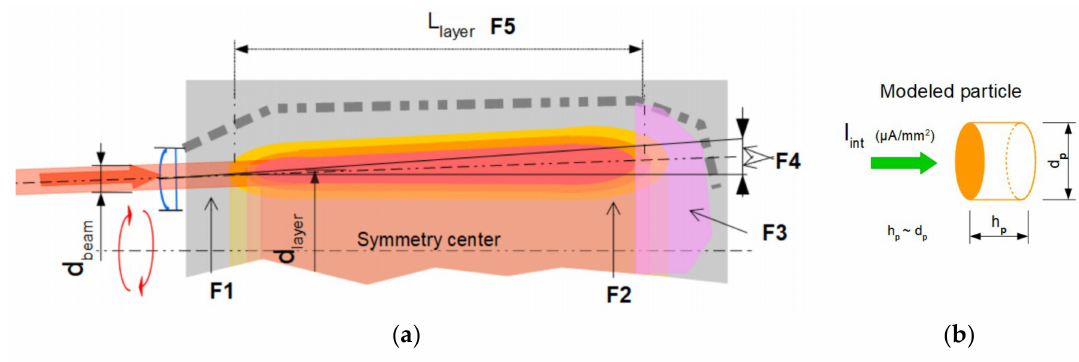
Figure 3. ( a ) Cross-sectional view of the powder layer in the irradiation chamber, where F1 is the entering beam at an energy of 14–30 MeV; F2 is the expected beam area at a threshold energy of 4–10 MeV; F3 is the area with the highest stopping power (Bragg Peak); F4 is the scattering-induced lateral range and straggling; and F5 is the length of the powder layer corresponding to thick targets setups. ( b ) Modeled